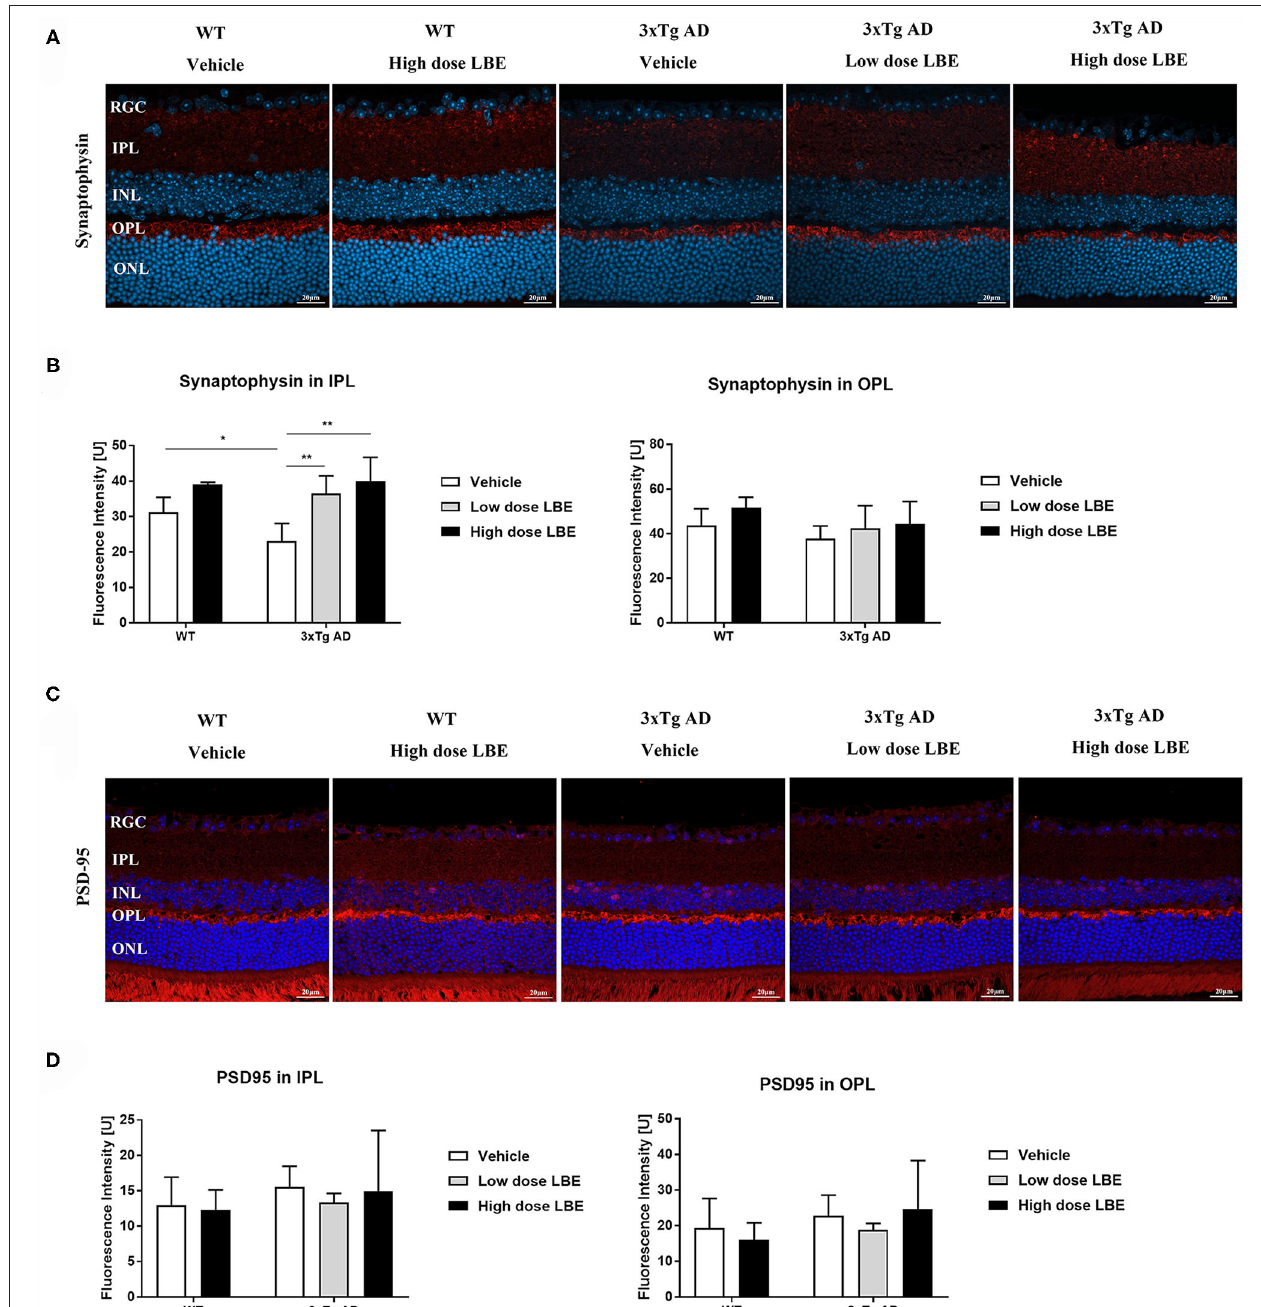
FIGURE 4 | LBE oral feeding significantly preserved presynaptic terminals in 3xTg-AD mice at 8 months of age. (A) Representative images of retinal sections stained for the presynaptic marker, synaptophysin, in 8 month old 3xTg-AD mice and age matched non-Tg control mice fed with water, low dose LBE or high dose LBE. Semi-quantification analysis revealed decreased presynaptic densities in the IPL but not the OPL in 8 month old 3xTg-AD mice, and rescue of the decrease by high dose LBE feeding [ (B) , * P < 0.05, ** p < 0.01]. Representative images of retinal sections stained for the postsynaptic marker, PSD-95, in 8 month old 3xTg-AD mice and age matched wild type mice fed with water, low dose LBE or high dose LBE (C) . No significant changes were observed in postsynaptic densities among all the groups (D)